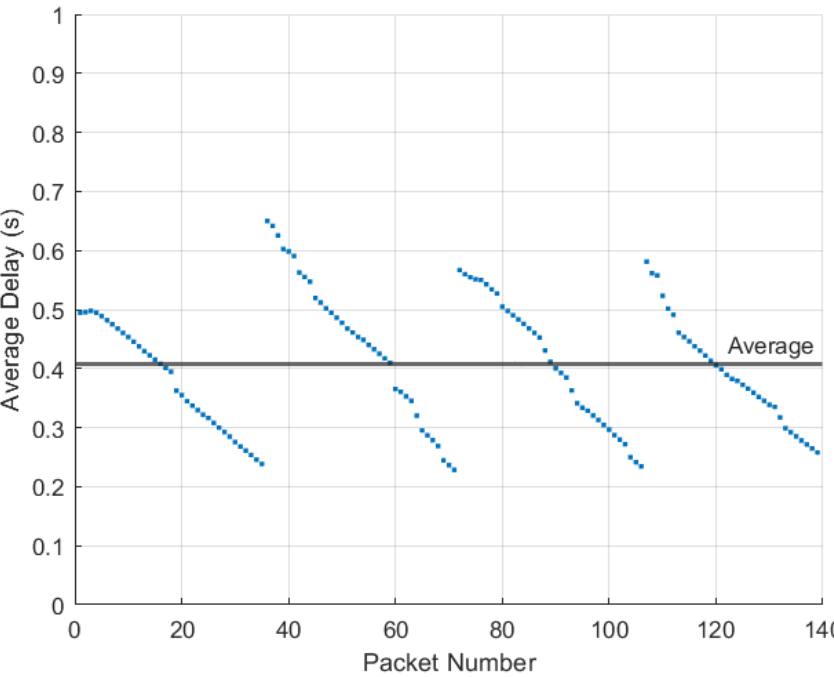
Figure 28. Flow-graph of average delay in seconds of the 120 packets transmitted during five trials over the 802.11p transmission from HackRF to